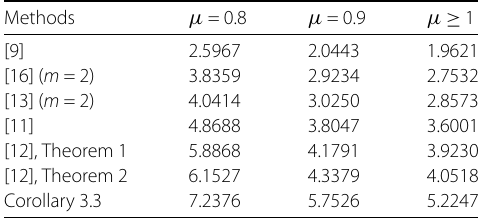
Table 2 The MADBs of τ M when τ m = 1 for different μ in Example